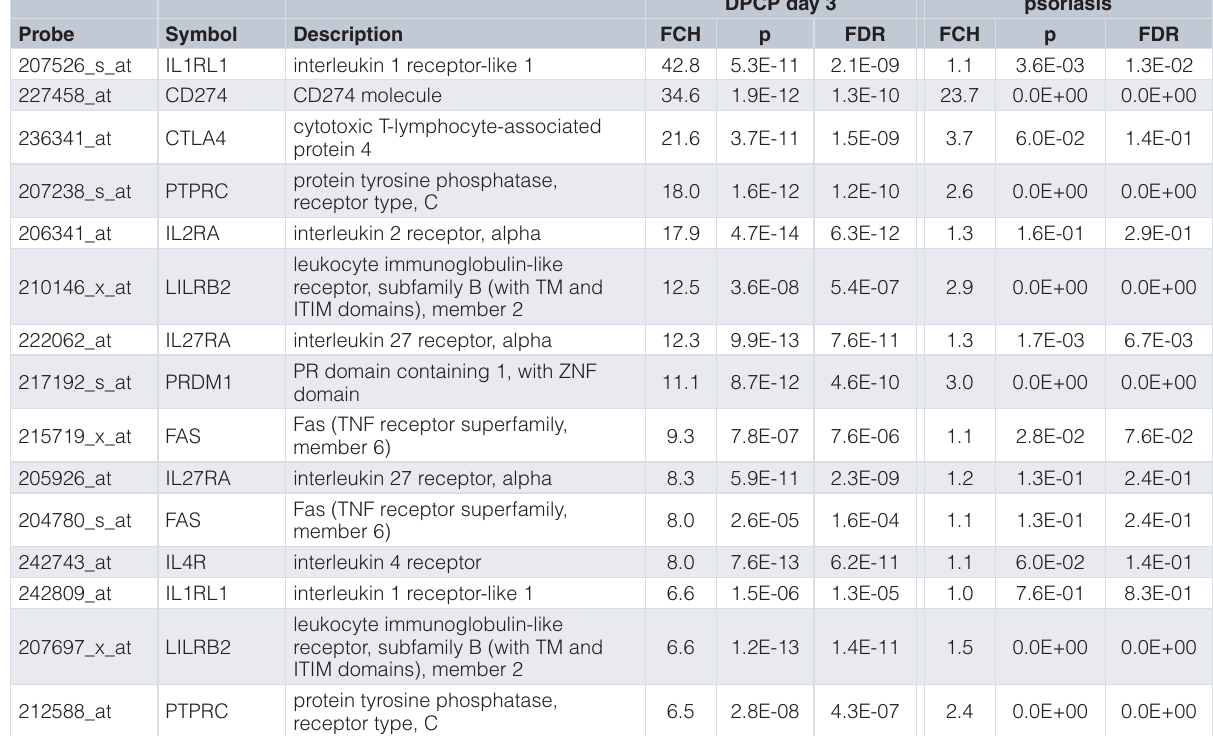
Table 1. Expression of negative regulator genes in DPCP day 3 vs. placebo and psoriasis lesional vs. non-lesional skin